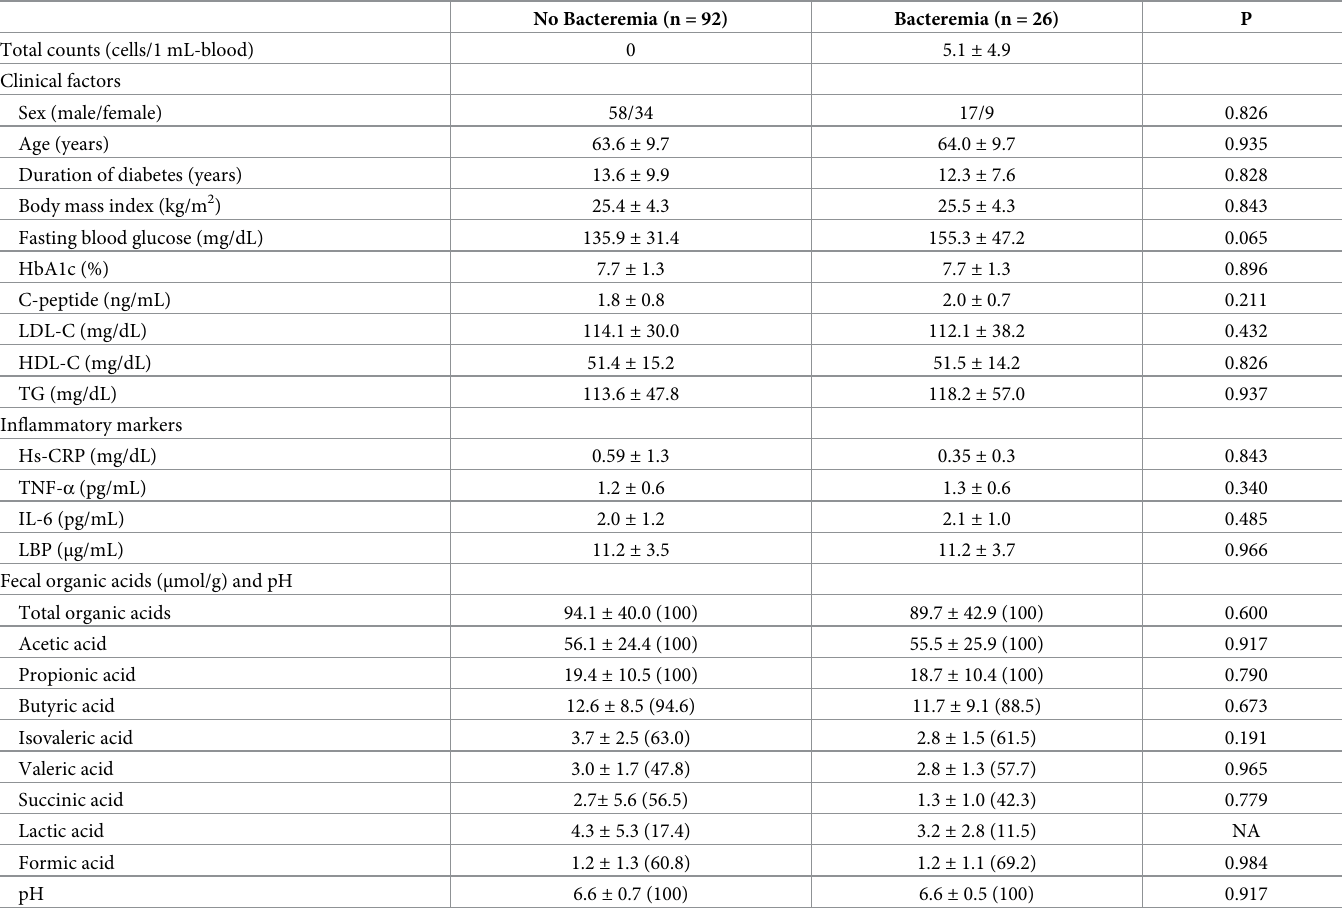
Table 2. Clinical characteristics of study subjects with and without